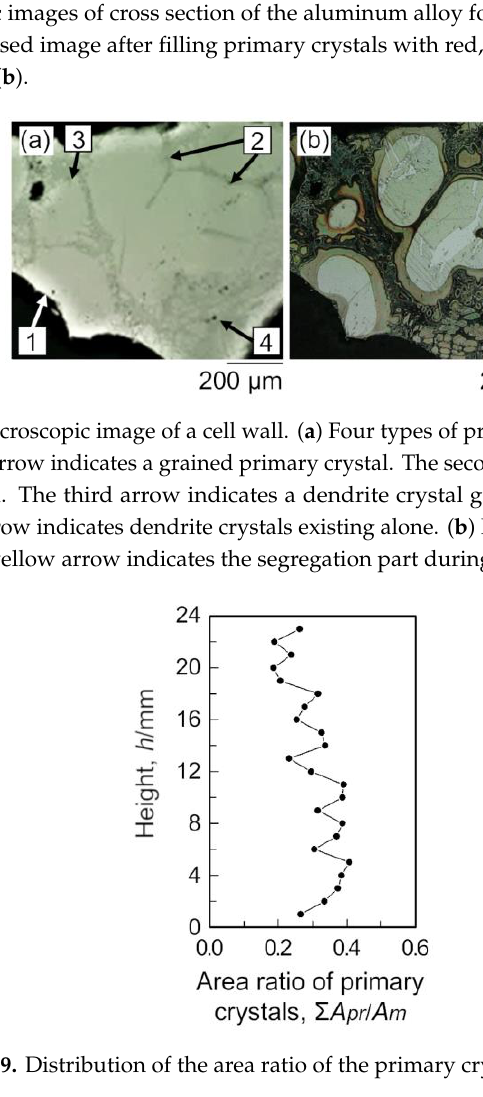
Figure 9. Distribution of the area ratio of the primary crystals, Σ A pr / A m .